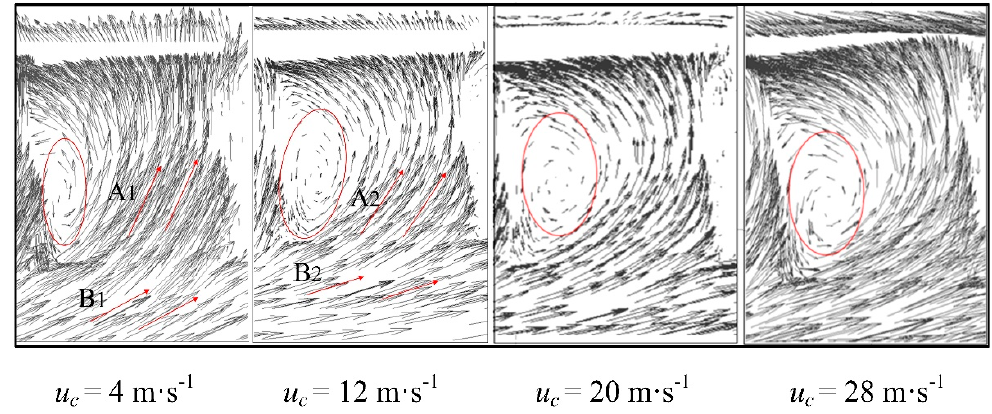
Figure 13. The velocity vectors of the transverse section.